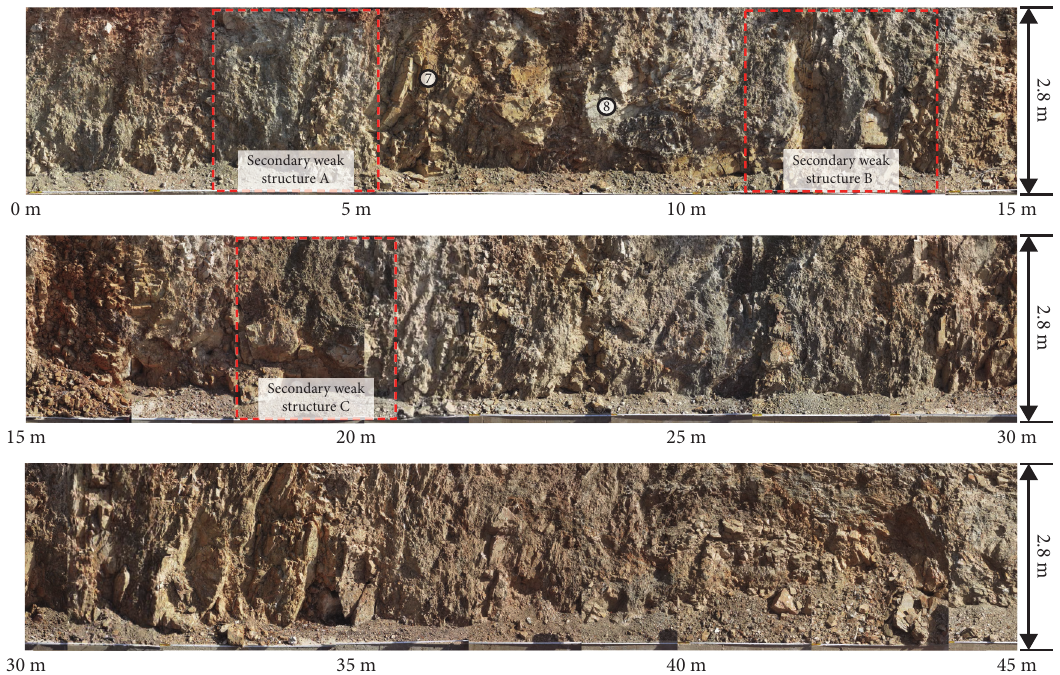
Figure 3: Outcrop profile of Jinshajiang main fault.